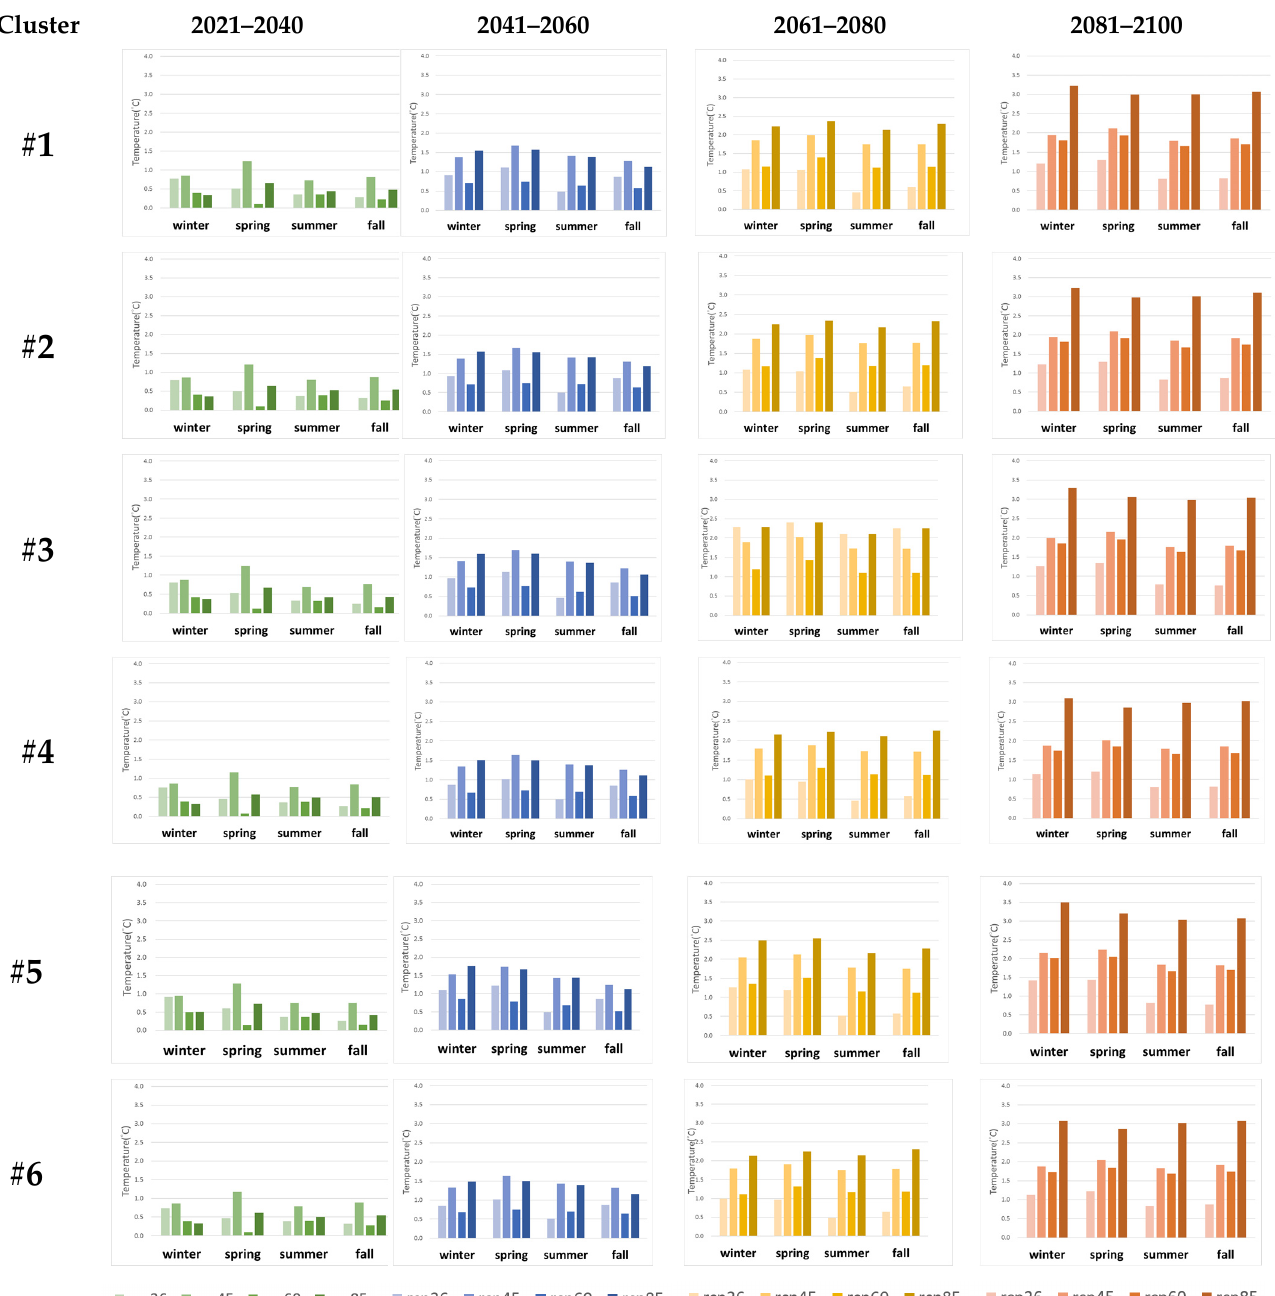
Figure A3. Seasonal rain change rate for each cluster under four RCP levels from 2021 to 2100.